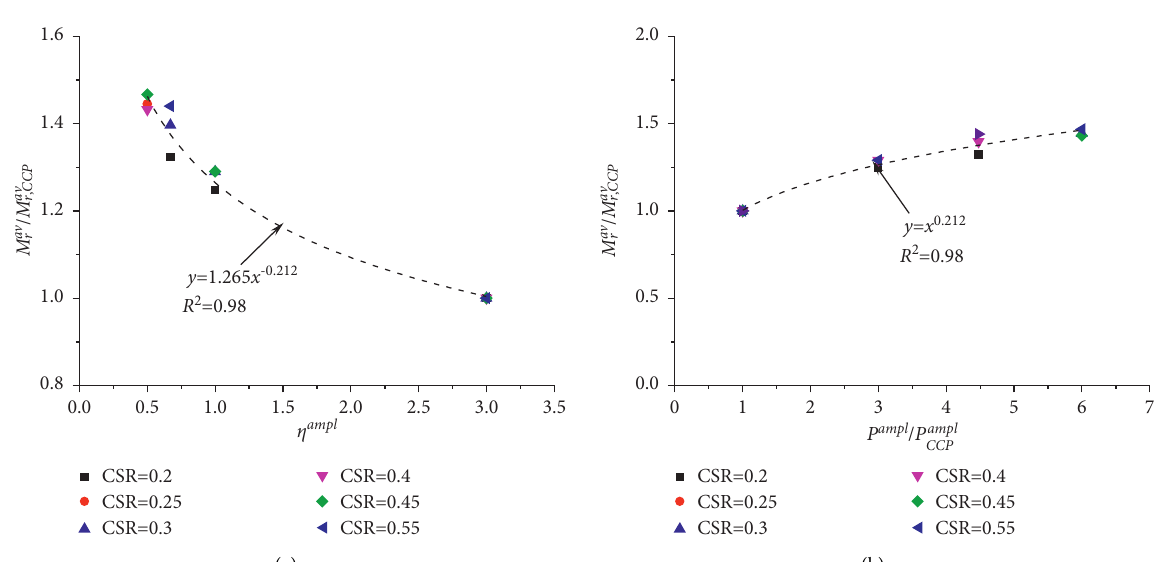
Figure 8: Normalized average resilient modulus as a function of (a) η ampl and (b) p ampl / p ampl